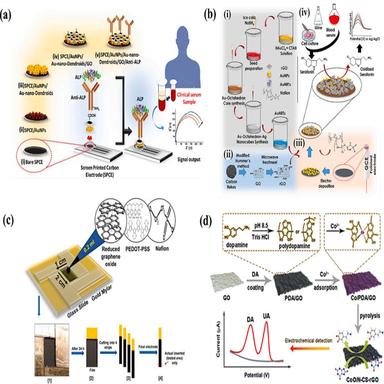
(a) A schematic for the fabrication of the SPCE/AuNPs/Au-nano dendroids/GO/anti-ALP biosensing probe for the quantitative measurement of ALP in clinical serum samples; Reproduced with permission. (b) Schematics for the synthesis of (i) AuNRTs, (ii) rGO, (iii) AuNPs and (iv) fabrication of biosensing platform and mechanism of serotonin detection on GCE; Reproduced with permission , (c) Schematics of the strip manufacturing process demonstrating the steps involved in creating a strip sensor mad